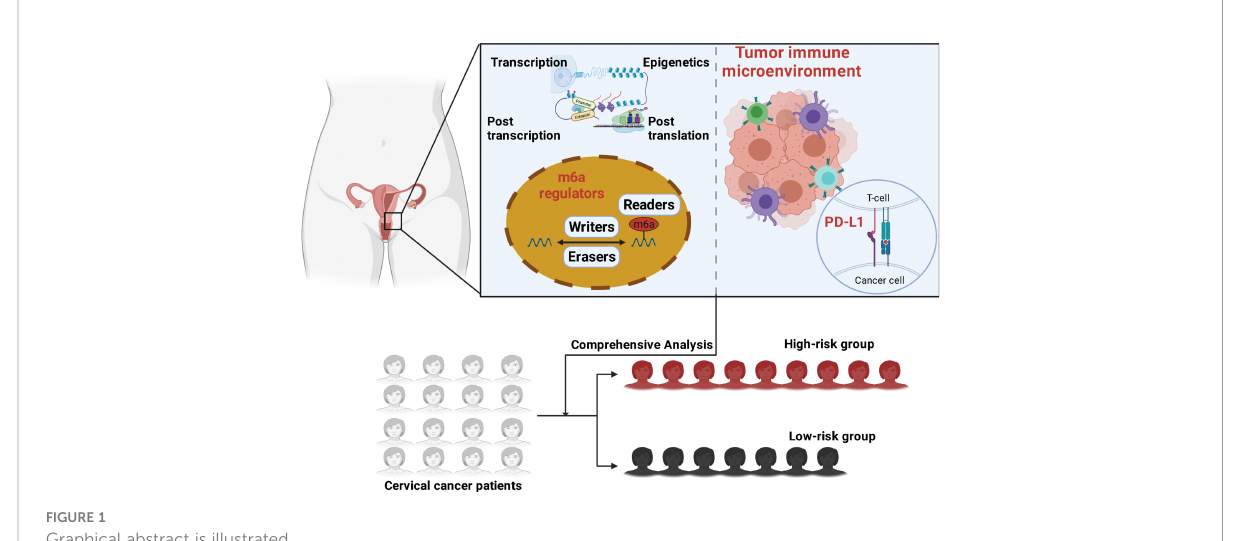
FIGURE 1 Graphical abstract is